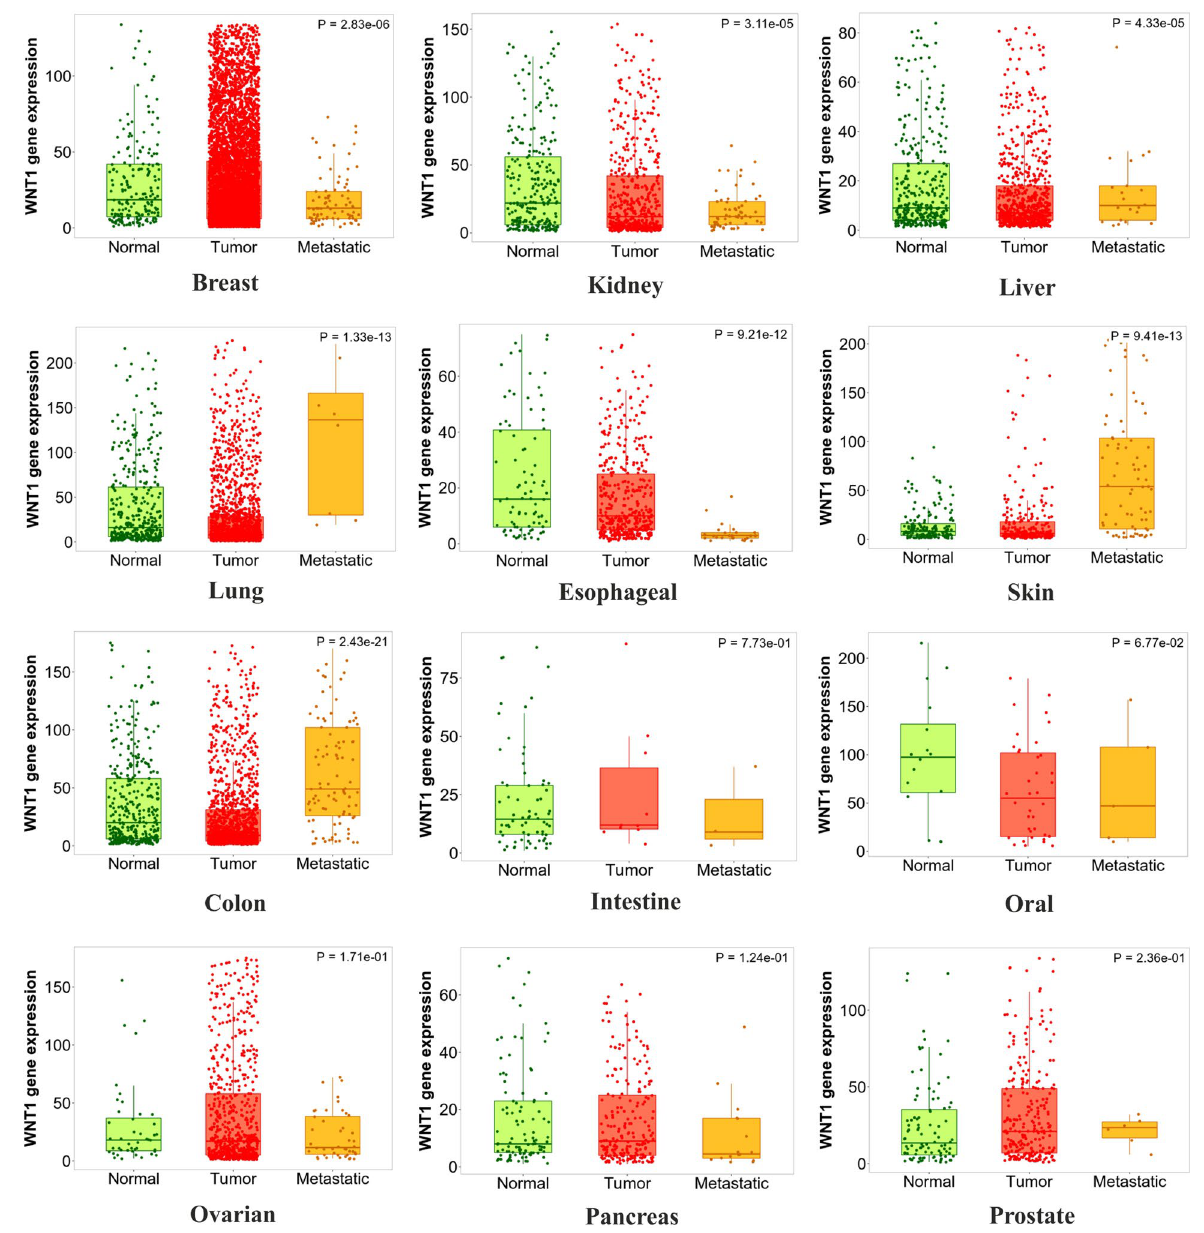
Figure 5. Comparative expression pattern of Wnt1 gene among various normal, tumor and metastatic tissue